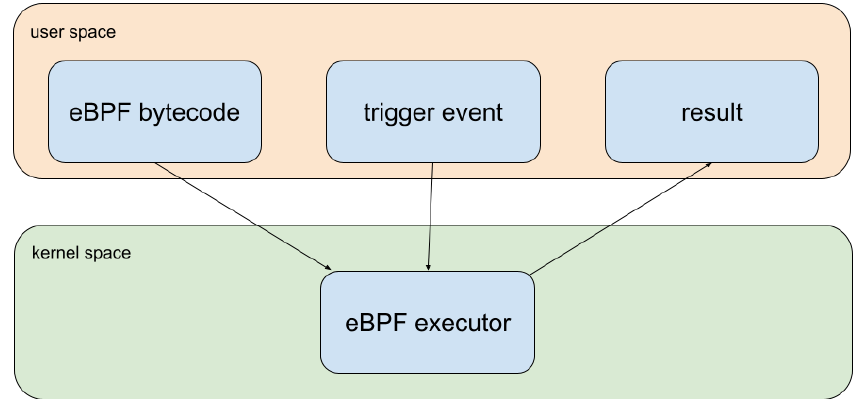
Figure 2. eBPF data